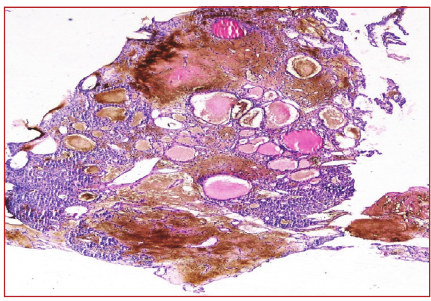
Figure 1: Dilated blood vessels in a loose stroma (H&E, × 10).